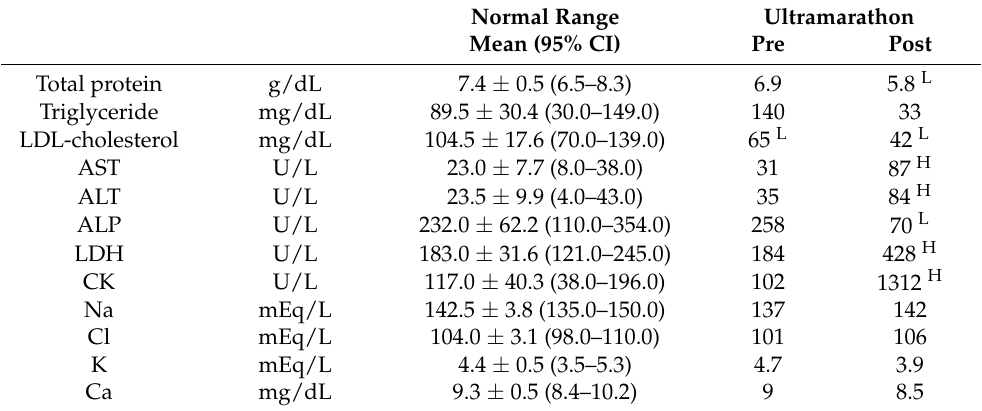
Table 2. Serum parameters pre- and post-ultramarathon compared with the Japanese population. Normal Range